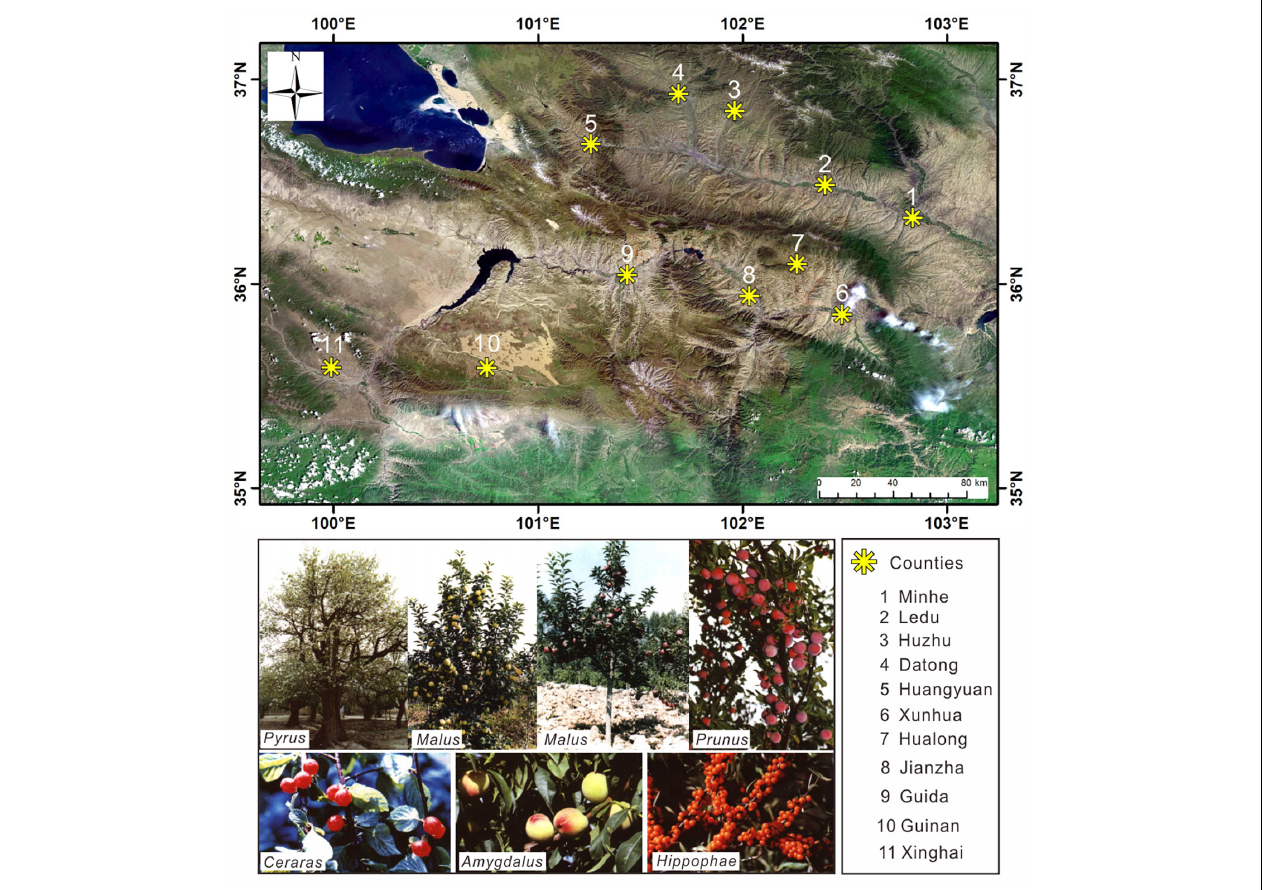
FIGURE 2 | Distribution of modern fruit-tree types in the NETP. The yellow gear-shaped symbols represent the counties with fruit cultivation, including Minhe, Ledu, Guide, Huzhu, Xunhua, Hualong, Jianzha, Guinan, Datong, Xinghai, Huangyuan, and